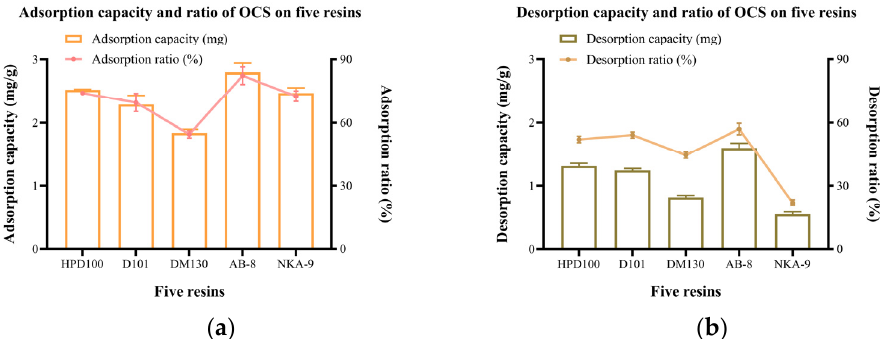
Figure 2. ( a ) Adsorption and ( b ) desorption capacity and rate on 5